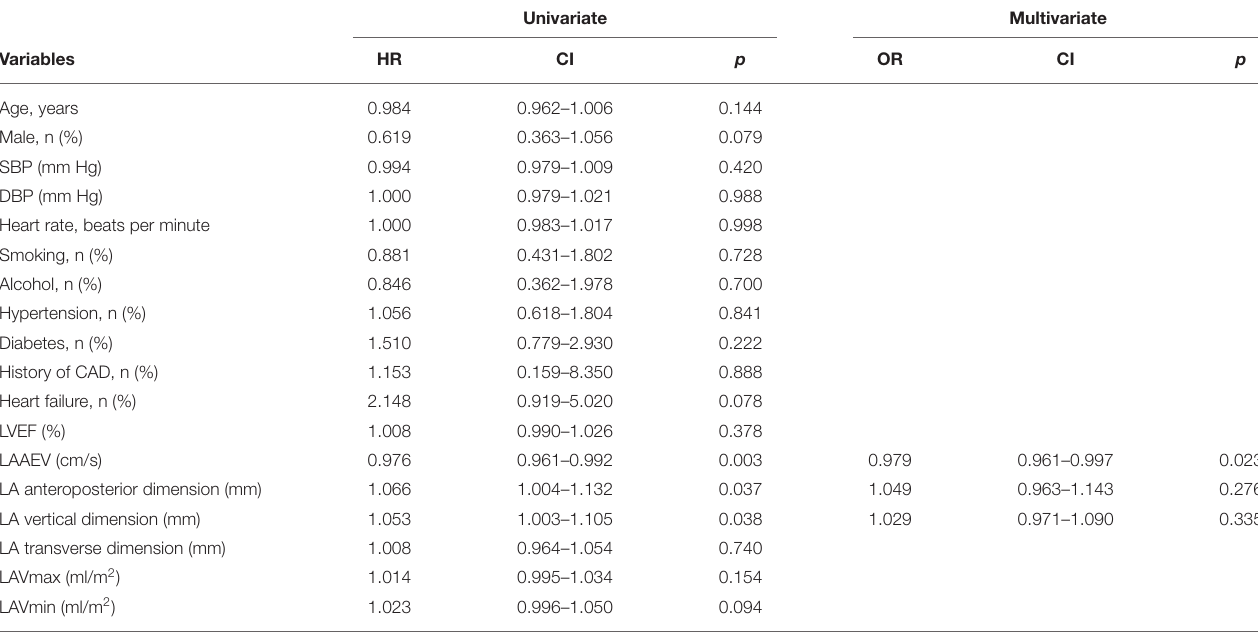
TABLE 4 | Univariate and multivariate Cox regression analysis to recognize predictors of AF recurrence after a single procedure. Univariate Multivariate